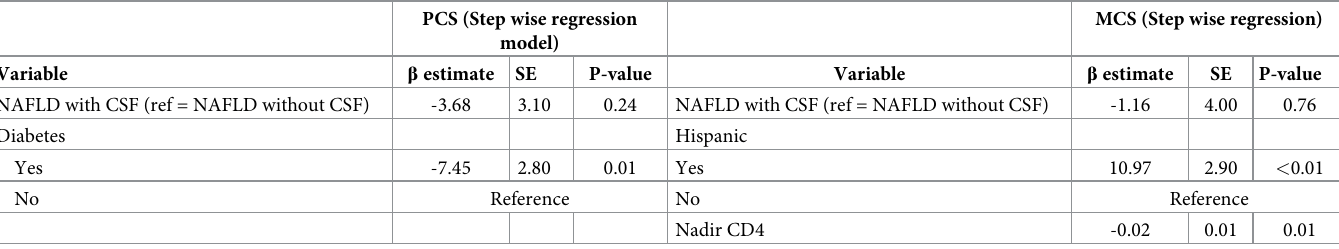
Table 3. Factors associated with health-related quality of life in persons with HIV based on multivariate analysis.